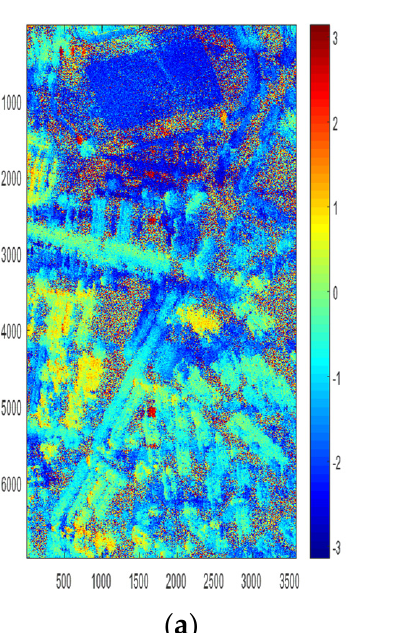
Figure 6. Decomposition results and Coherence. ( a ) Pseudo color image. ( b ) Image of polarimetric Interferometric optimal decomposition. ( c ) Coherence of single scattering. ( d ) Coherence of polari- metric interferometric optimal decomposition.